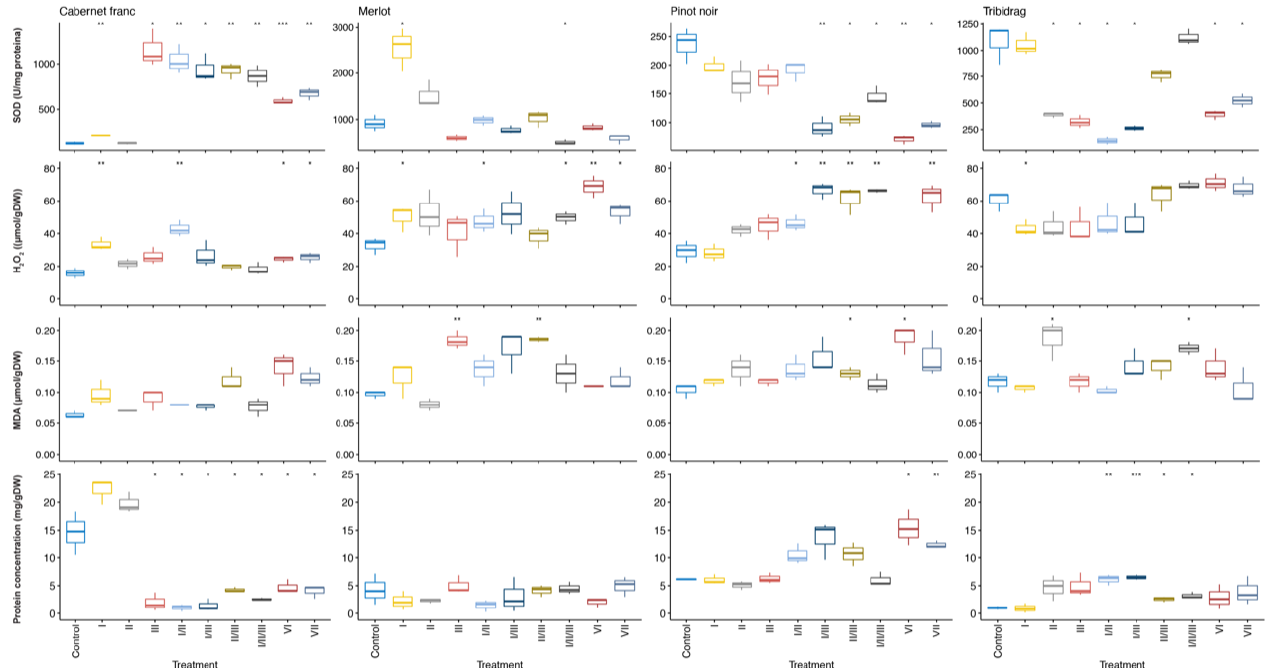
Figure 4. Differences in superoxide dismutase (SOD), hydrogen peroxide (H 2 O 2 ), malondialdehyde (MDA), and proteins caused by leafroll (LR) genotypes in 2021 compared to control plants in ‘Cabernet Franc,’ ’Merlot, ‘Pinot Noir’ and ‘Tribidrag’ grapevine varieties as analyzed by t -test. Significant differences are indicated with asterisks as follows: ‘*’indicates p < 0.05, ‘**’ indicates p < 0.01 and ‘***’ indicates p <